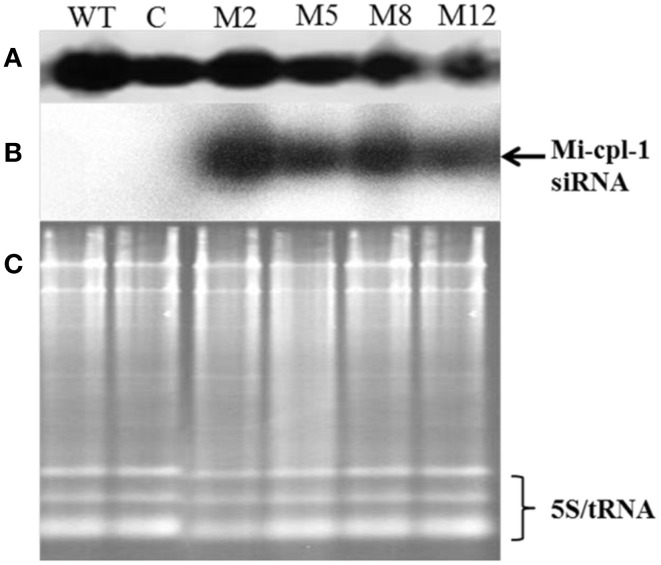
Production of Mi-cpl-1-specific small RNAs in transgenic tomato plants.(A) Northern blot for U6 small nuclear RNA as control, (B) Northern blot showing Mi-cpl-1 siRNAs hybridizing with probe Mi-cpl-1, and (C) Agarose gel showing total RNA loading control in Tomato “Pusa Ruby” wild type (WT), transgenic empty pHELLSGATE12 vector control (C), and transgenic pHELLSGATE12-Mi-cpl-1 (M2, M5, M8, M12) plants.